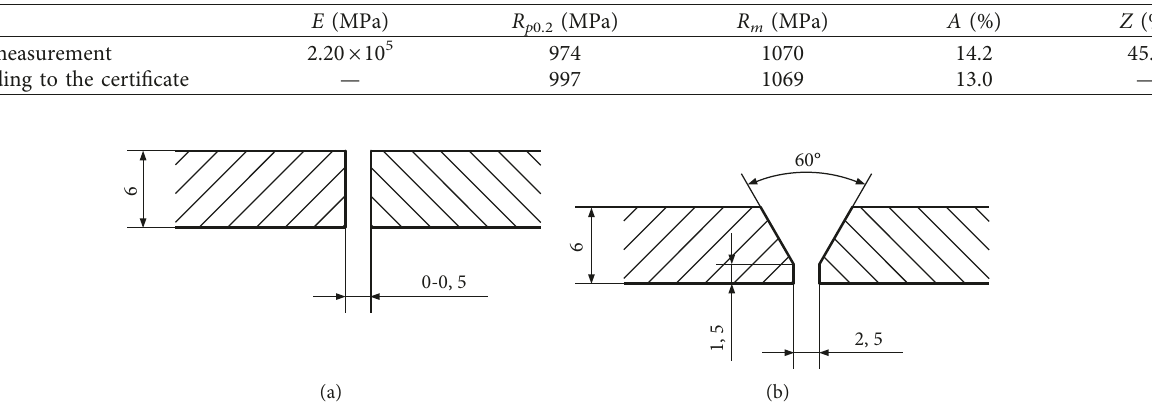
Table 2: Mechanical properties of S960QL steel.